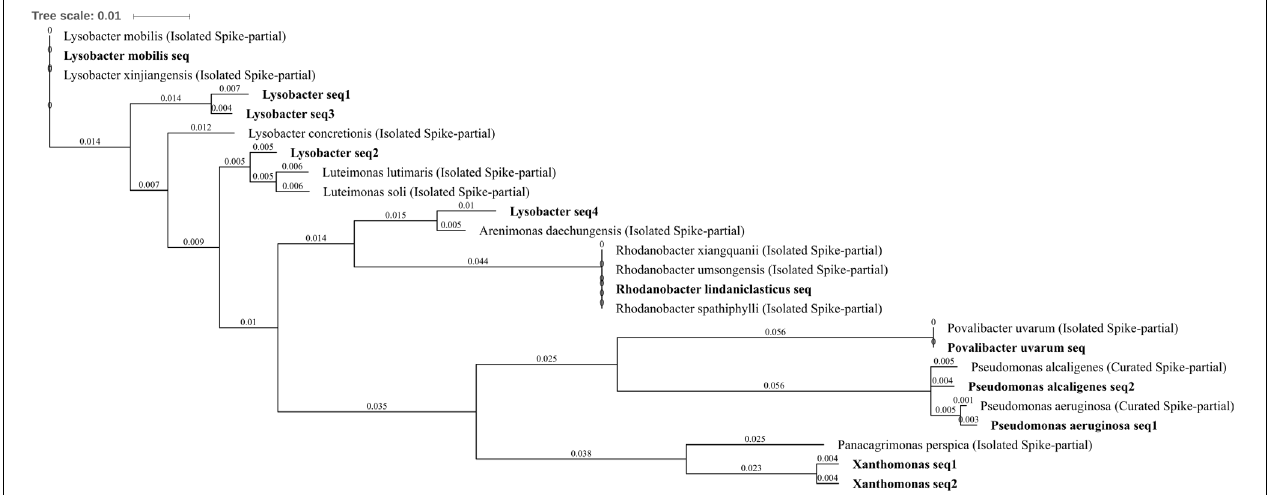
FIGURE 8 | Gammaproteobacteria phylogenetic tree. Jukes–Cantor model with neighbor-joining and > 50% support threshold (1,000 replications). Sub-OTUs (distinct amplicons) are highlighted in bold with spike (into the tree) sequences included as the most similar hits from the NCBI bacteria and archaea 16S rRNA gene database. All accession numbers and sequences (sub-OTUs and tree spikes) are provided in Supplementary File 2 . The value “0.01” on the scale bar represents 1 substitution in 100